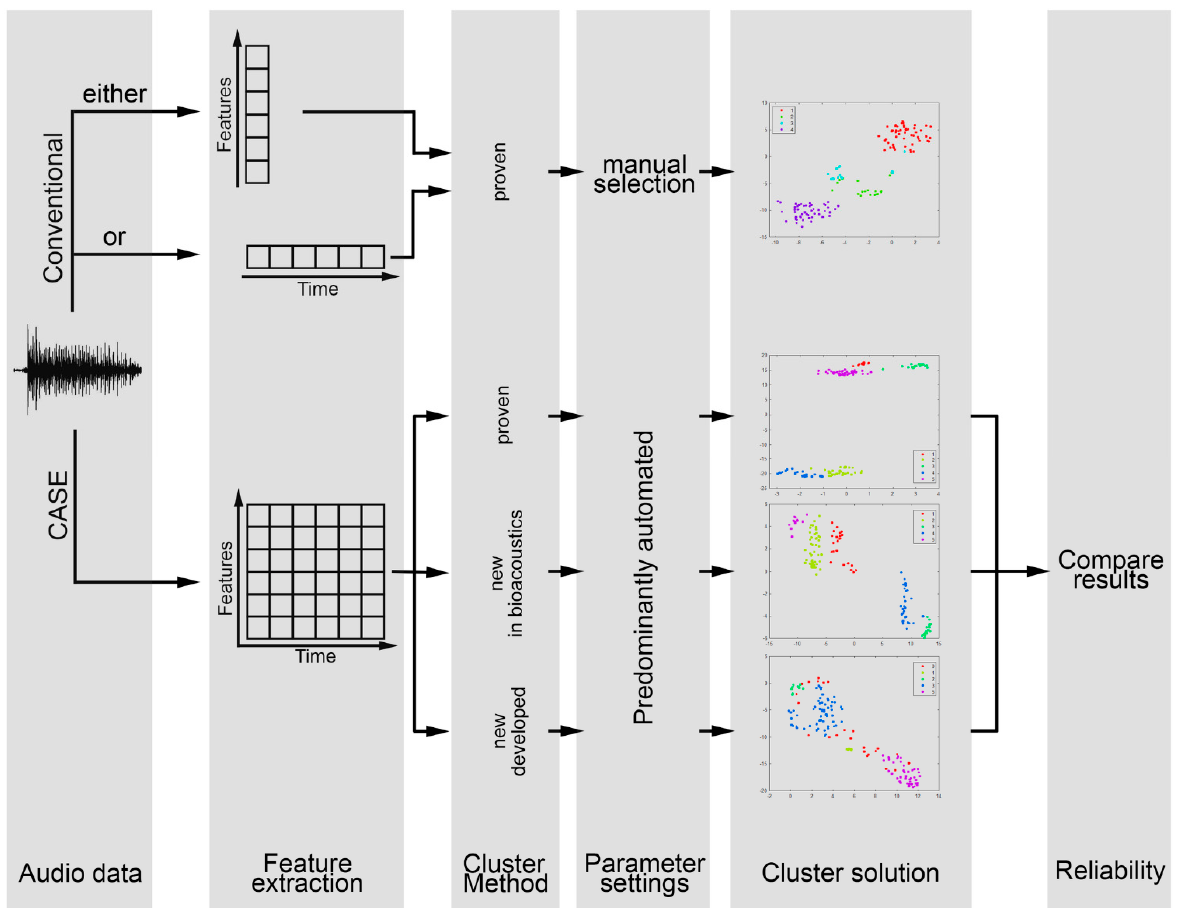
Figure 2. Illustration of the advantages of the software CASE in comparison with conventional ap- proaches using one-dimensional feature vectors as inputs for a single clustering algorithm. We used two different data sets here to test the clustering methods. On the one hand, vocalizations of two harpy eagles ( Harpia harpyja ) at Nuremberg Zoo were used, and co- hesion calls of a group of giant otters ( Pteronura brasiliensis ) at Dortmund Zoo were used harpy eagle. Using the harpy eagle vocalizations, how well the clustering methods can distinguish between different slightly frequency-modulated vocalizations of the same